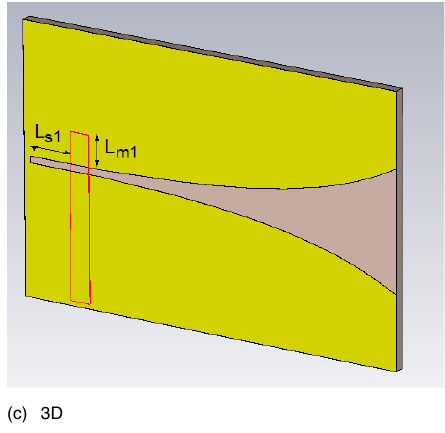
FIGURE 1. The Vivaldi antenna